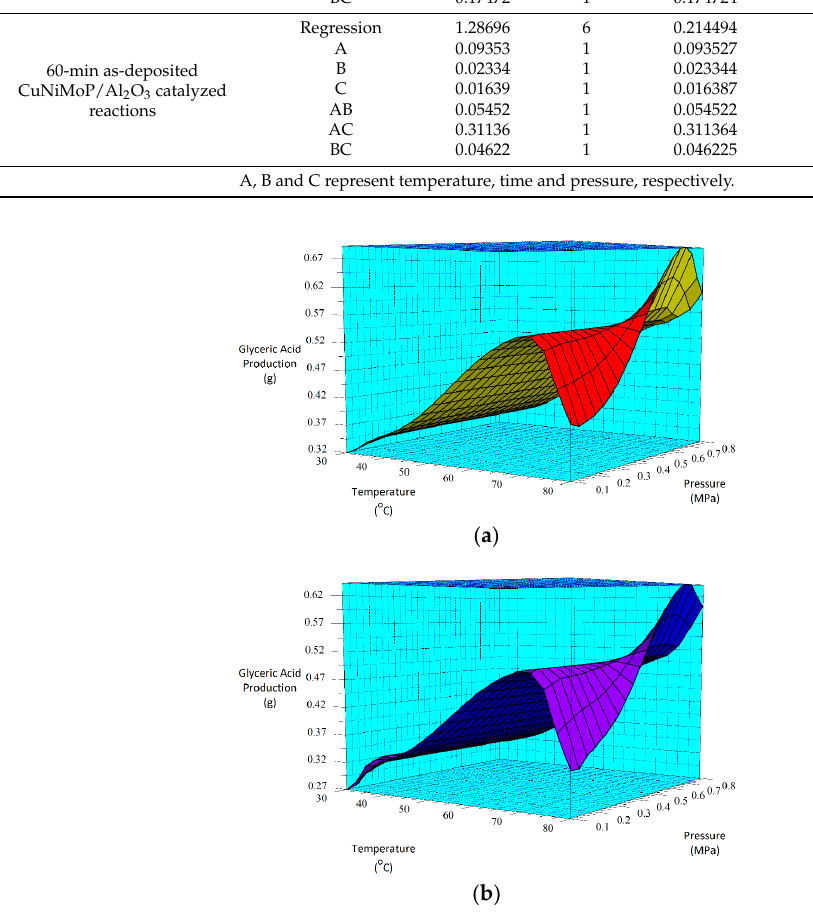
Figure 5. 3D surface plots for glyceric acid production for ( a ) the 30-min and ( b ) the 60-min as-deposited electroless CuNiMoP/Al 2 O 3 oxidation reactions.